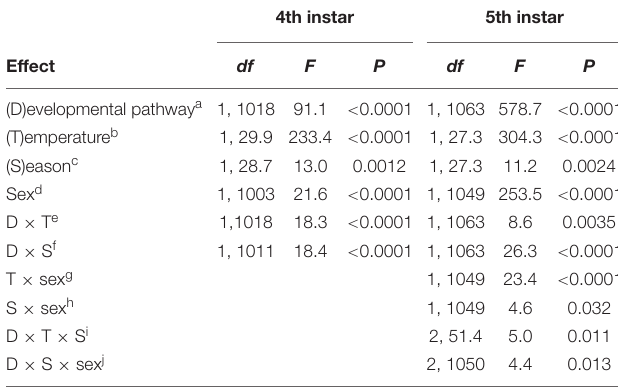
TABLE 2 | Duration of active growth phase (from molt until attainment of peak body mass) in the 4th and 5th instar Araschnia levana larvae as explained by developmental pathway, temperature, season, and sex; linear mixed models (SAS, Proc MIXED, type 3 sums of squares) with brood (progeny of one female) as a random effect.